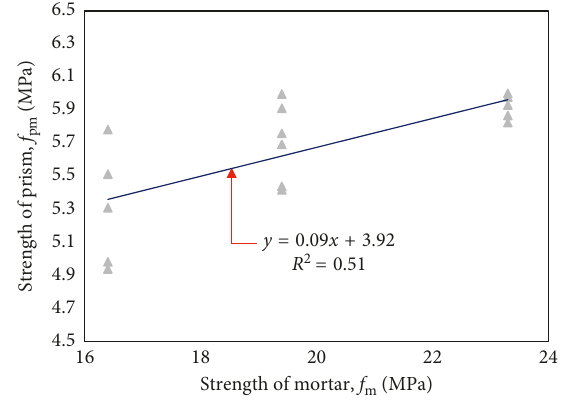
Figure 5: Regression analysis for f